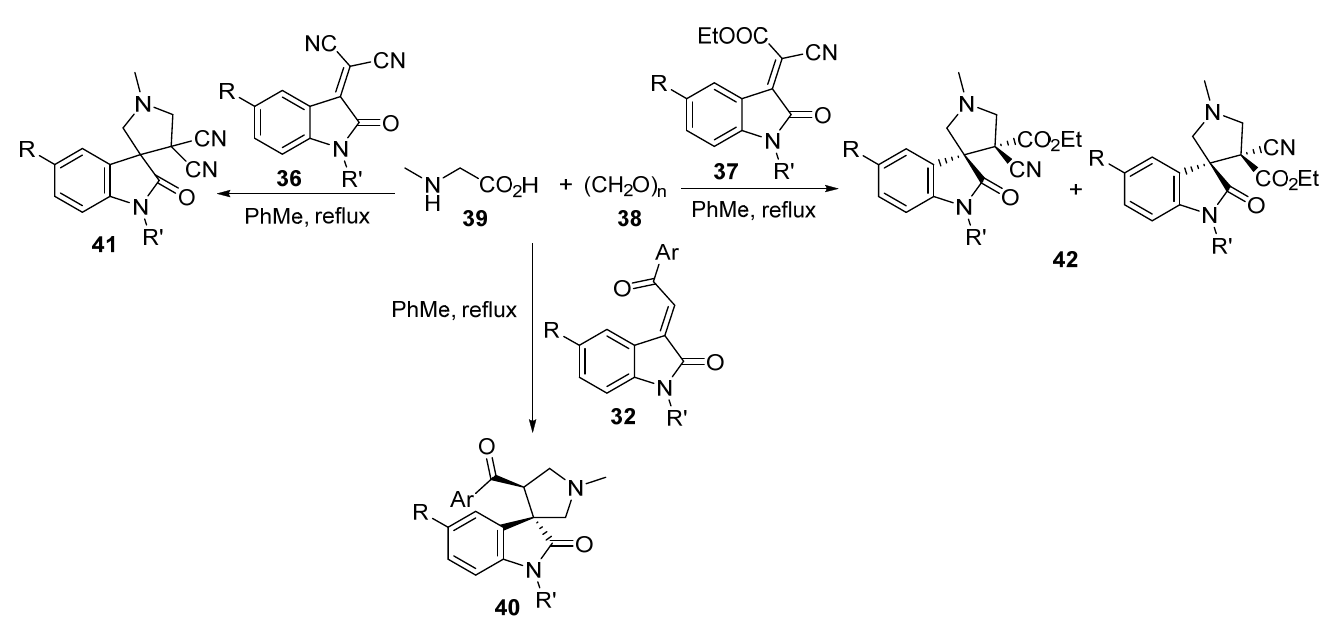
Molecules 2023 , 28 , 618 8 of 34 Scheme 6. Synthesis of spiro[indoline-3,4’-pyrimidin]-2-ones 34 .